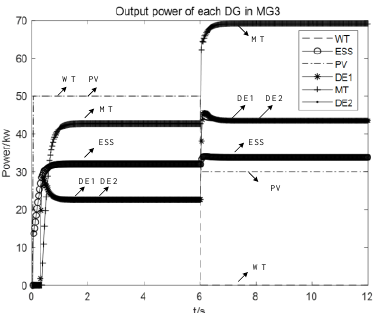
Figure 14. Output power of each DG.